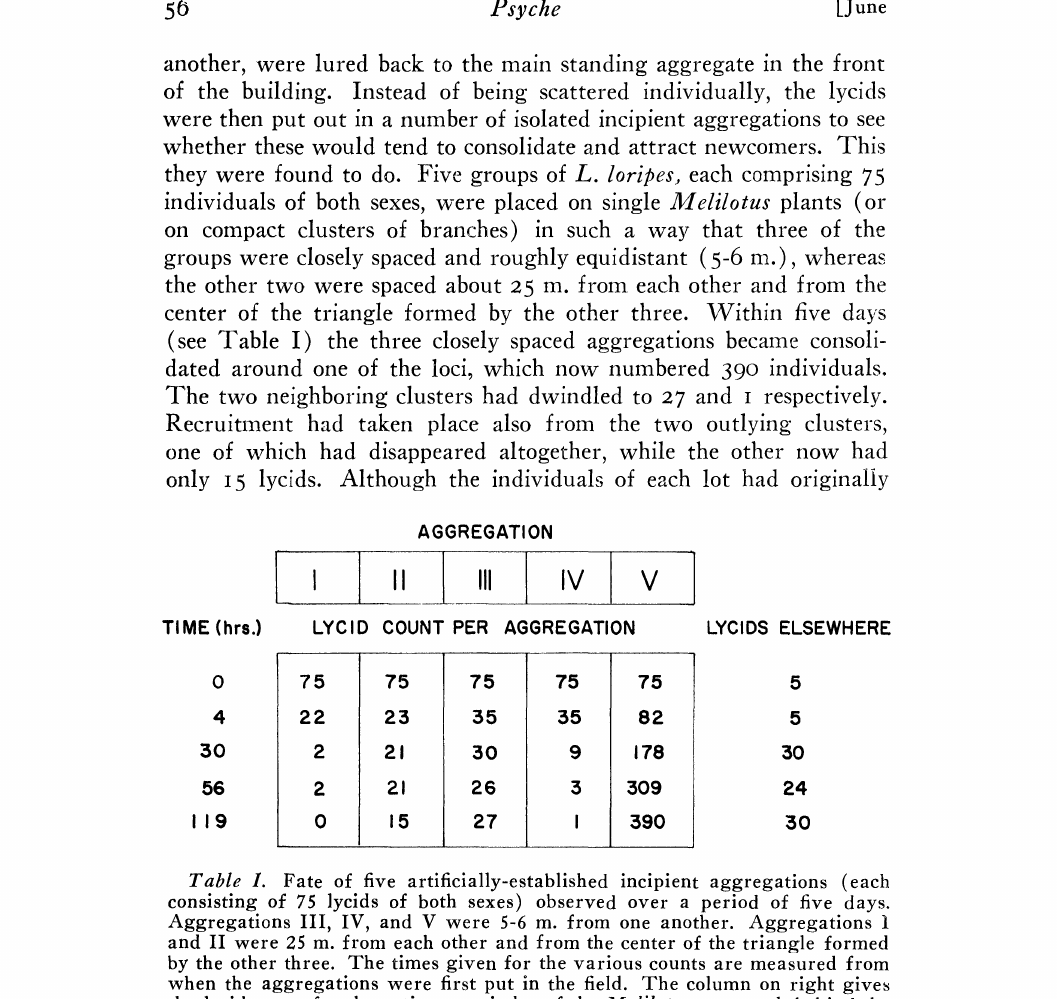
Table I. Fate of five artificially-established incipient aggregations (each consisting of 75 lycids of both sexes) observed over a period of five days. Aggregations III, IV, and V were 5-6 m. from one another. Aggregations and II were 25 m. from each other and from the center of the triangle formed by the other three. The times given for the various counts are measured from when the aggregations were first put in the field. The column on right gives the lycid count for the entire remainder of the Melilotus test patch behind the laboratory building. EXPLANATION OF PLATE zl- Figure 1. One of the nets (enclosing Melilotus with lycids) used as a lure. This particular net, which held males alone, was one that successfully attract- ed other lycids (a few of the newcomers are seen on the net itself). Figure 2. Group of male lycids, in the typical sequential arrangement they often assume when confined by